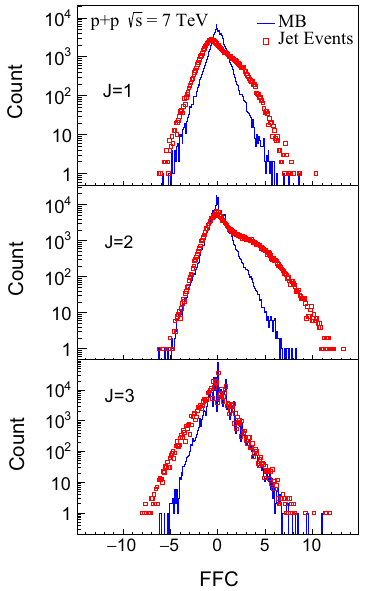
√ Fig. 4 FFCs distribution for scale J=1, 2, 3 in pp collisions at s = 7TeV from Digits. The jet events have jet E T > 20 GeV